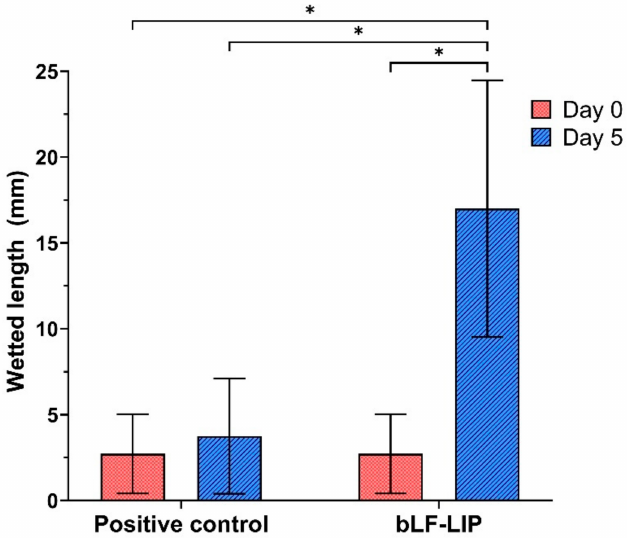
Figure 7. Schirmer’s test results. Values are expressed as mean ± SD; * p < 0.05 significantly higher than the secreted tear by non-treated with bLF-LIP eye for 5